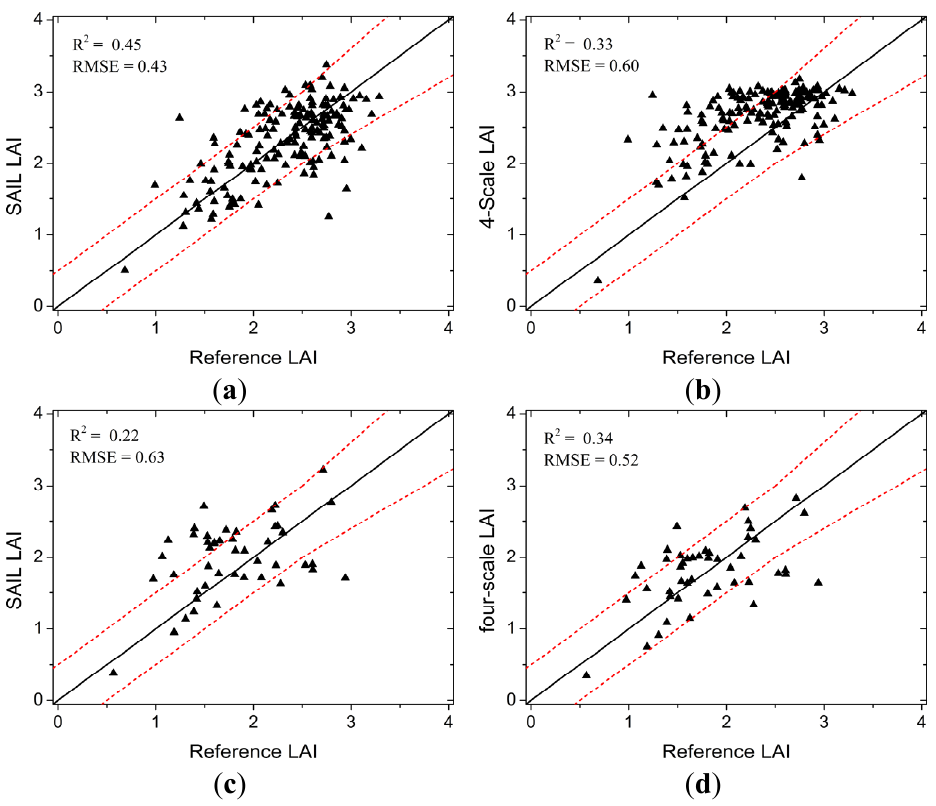
Figure 5. Comparison between SAIL LAI ( a ) and four-scale LAI ( b ) in croplands and SAIL LAI ( c ) and four-scale LAI ( d ) in forests with the corresponding reference LAI. The solid lines represent the 1:1 lines, and the dotted lines represent the accuracy boundaries (max (0.5, 20%)) specified by the Global Climate Observation System